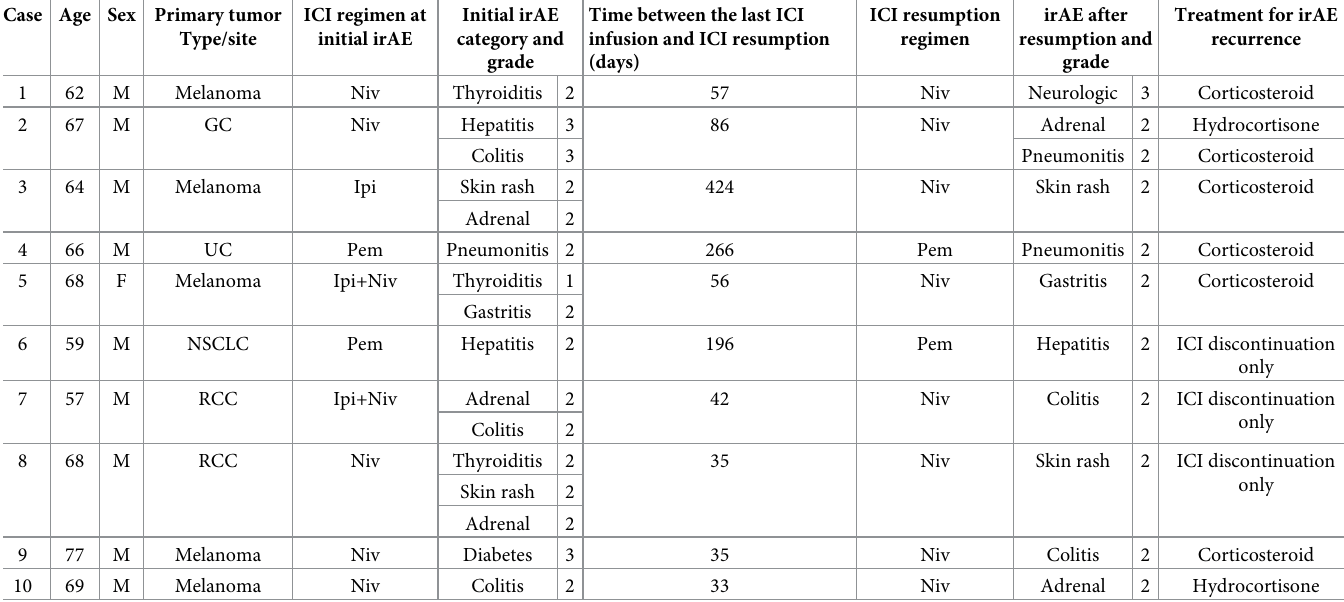
Table 2. Clinical courses of patients with recurring grade � 2 irAEs after ICI resumption. Case Age Sex Primary tumor